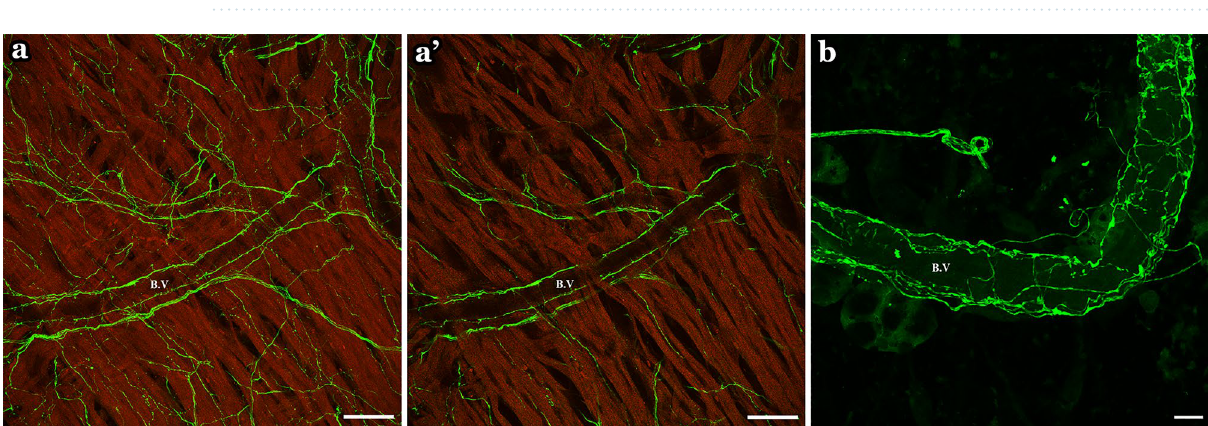
Figure 12. Small intensely fluorescent (SIF) cells in the atria. ( a ) TH-IR SIF cells were grouped into clusters of 3–8 and expressed stronger TH-IR labeling than TH-IR neurons in the ICG. ( a’ , a’’ ) Two optical sections showed two separate SIF cell clusters in the dotted boxes in a indicating the intense labeling and small diameter (< 10 μm) of SIF cells. Zoom 1.5X ( a ), Zoom 2X ( a’,a’’ ). Scale bar: 20 μm.